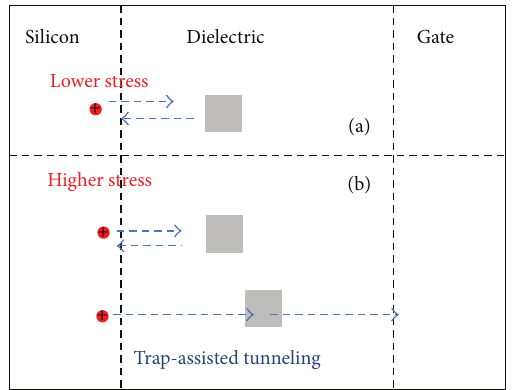
Figure 7: Schematic view of the switching traps in pMOSFETs. Under low gate bias, the switching traps in oxide layer could only be recovered by exchanging hole with channel and induce only 𝐼 𝐷 - RTN. Under the high gate bias, part of generated switching traps can captureandholdtheholewhilesomeotherstransformtheholefrom the channel to gate by TAT